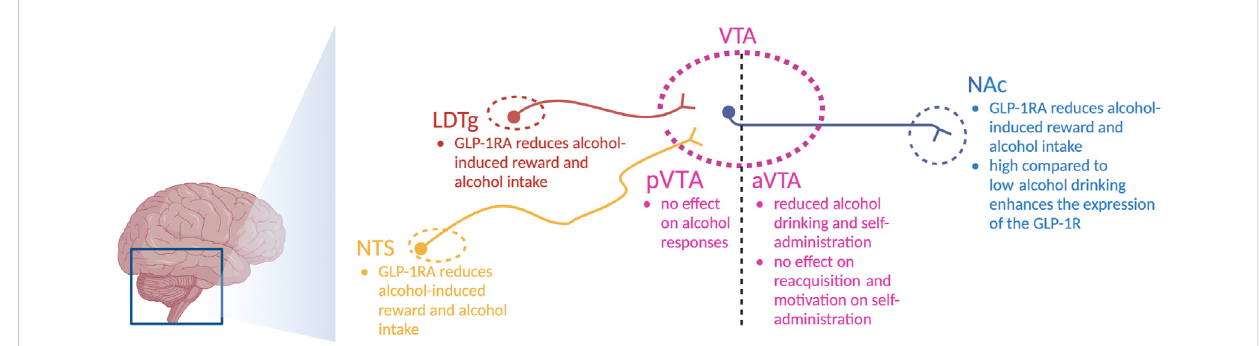
FIGURE 2 Schematic illustration of selected areas in which GLP-1 receptor agonists act to regulate alcohol-related responses in rodents. Indicated are the nucleus of the solitary tract (NTS), nucleus accumbens (NAc), ventral tegmental area (VTA), anterior VTA (aVTA), posterior VTA (pVTA),